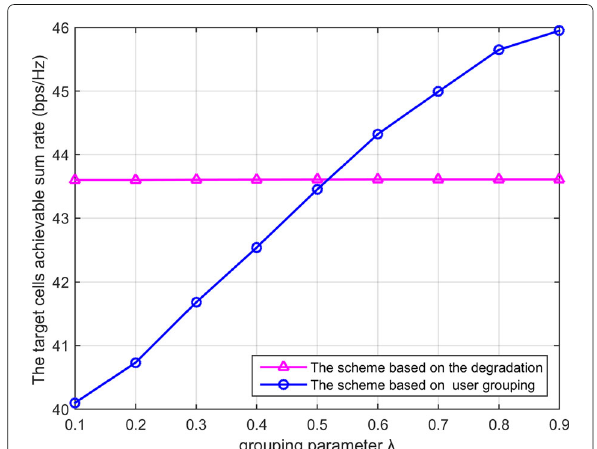
Fig. 5 The impact of the number of BS antennas on the SINR of edge users in target cell